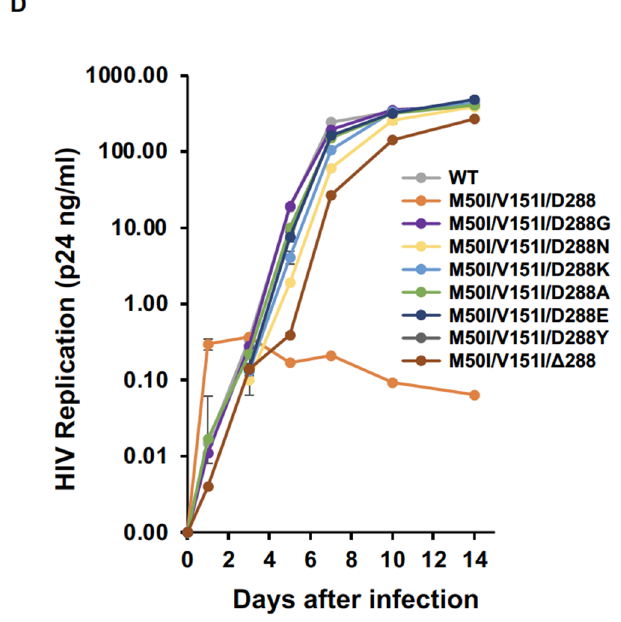
Figure 5. The C-terminus amino acid residue, Asp, regulates virus release and processing of HIV(M50I/V151I). ( A ) Each construct was transfected into HEK293T cells. Transfection supernatants from the HEK293T cells were collected, and viral particles were pelted as described in the Materials and Methods (Section 2.4). Each viral pellet was resuspended in 1/100 of the transfection supernatants in complete culture media. Viral concentration was determined by measuring HIV p24 antigen by ELISA. Data indicate means ± SEs (n = 5). Statistical analysis was conducted using one-way ANOVA. ( B , C ) Each virus particle was isolated from the transfection supernatant as described in the Materials and Methods (Section 2.4), and 1 μ g of each viral lysate was subjected to WB. Gag- and GagPol-cleaved products and PR were detected by polyclonal anti-p17/p24/gag ( B ) and anti-PR ( C ). ( D ) PHA-stimulated primary CD4(+) T cells derived from healthy donors were infected with 10 ng p24 amounts of HIV(WT) or variants containing mutations, as described in the Materials and Methods (Section 2.5). The infected cells were cultured for 14 days with the medium change every 3 to 4 days. HIV replication was monitored using a p24 antigen capture kit. Representative data from three independent assays are presented as means ± SDs (n = 3). *: p < 0.05, **: p < 0.01, ***: p < 0.001, ****: p < 0.0001, ns.: not significant.